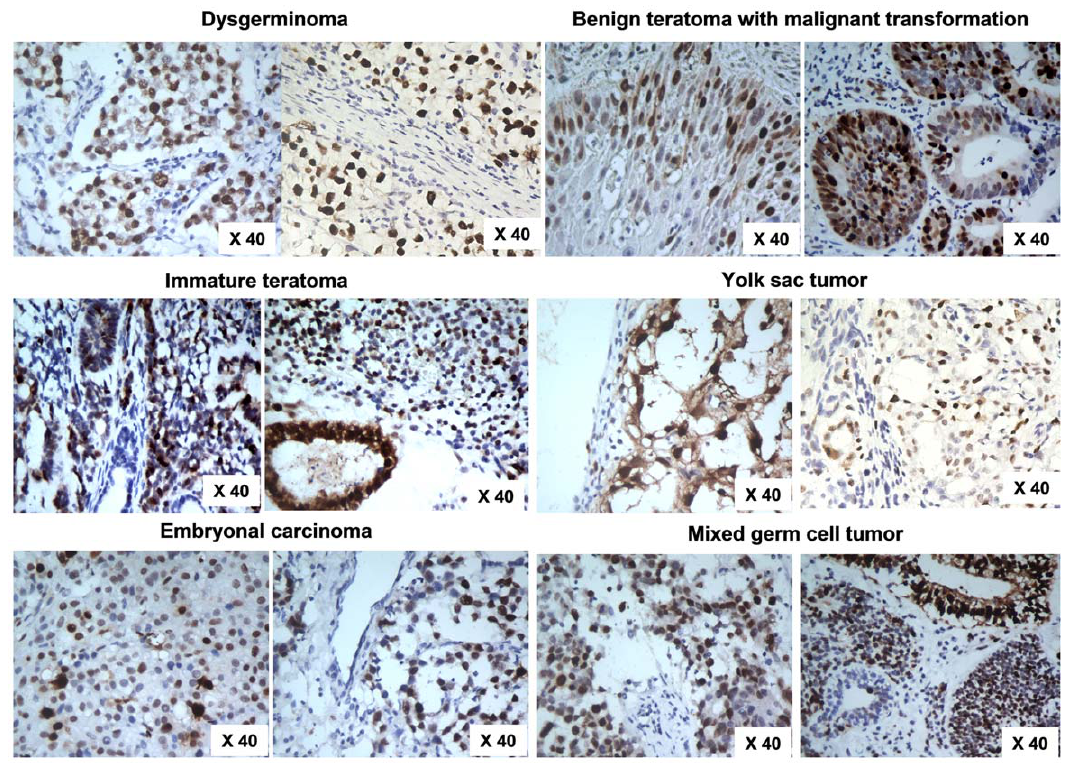
Figure 3. KPNA2 and SALL4 expression in OMGCT at the translation level. Positive IHC staining in dysgerminoma, benign teratoma with malignant transformation, immature teratoma, yolk sac tumor, embryonal carcinoma, and mixed germ cell tumor (Ori. mag. 6 40).